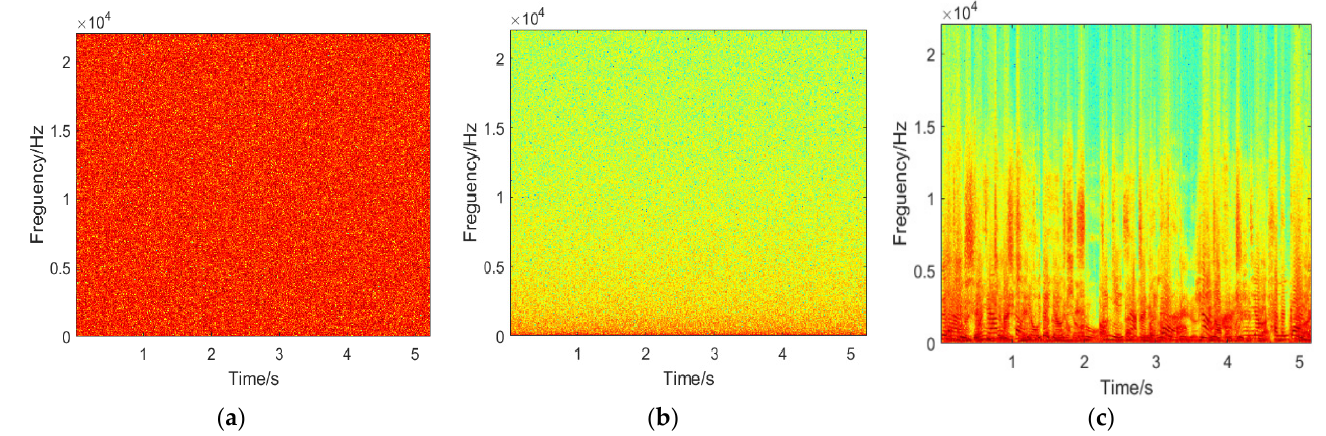
Figure 2. Spectrograms of three types of noise. ( a ) White noise; ( b ) pink noise; ( c ) speech noise.